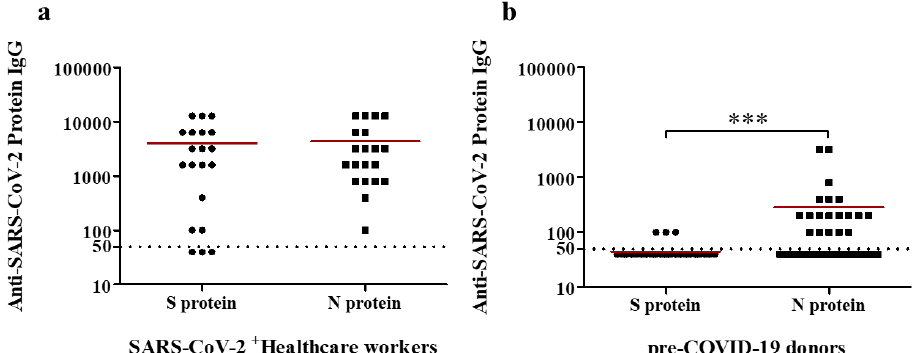
Figure 2. Analysis of serum IgG antibodies against SARS-CoV-2 S and N proteins in healthcare workers with COVID-19 and pre-COVID-19 samples determined by ELISA assay. Cutoff values to determine positive (above), and negative (below dashed line) samples is indicated. Dots and squares represent anti-SARS-CoV-2 S and N protein IgGs, respectively, from healthcare workers affected by COVID-19 ( a ) or pre-pandemic samples ( b ). Means (red lines) and significant P values (***, p < 0.001 Mann Whitney test) are indicated.